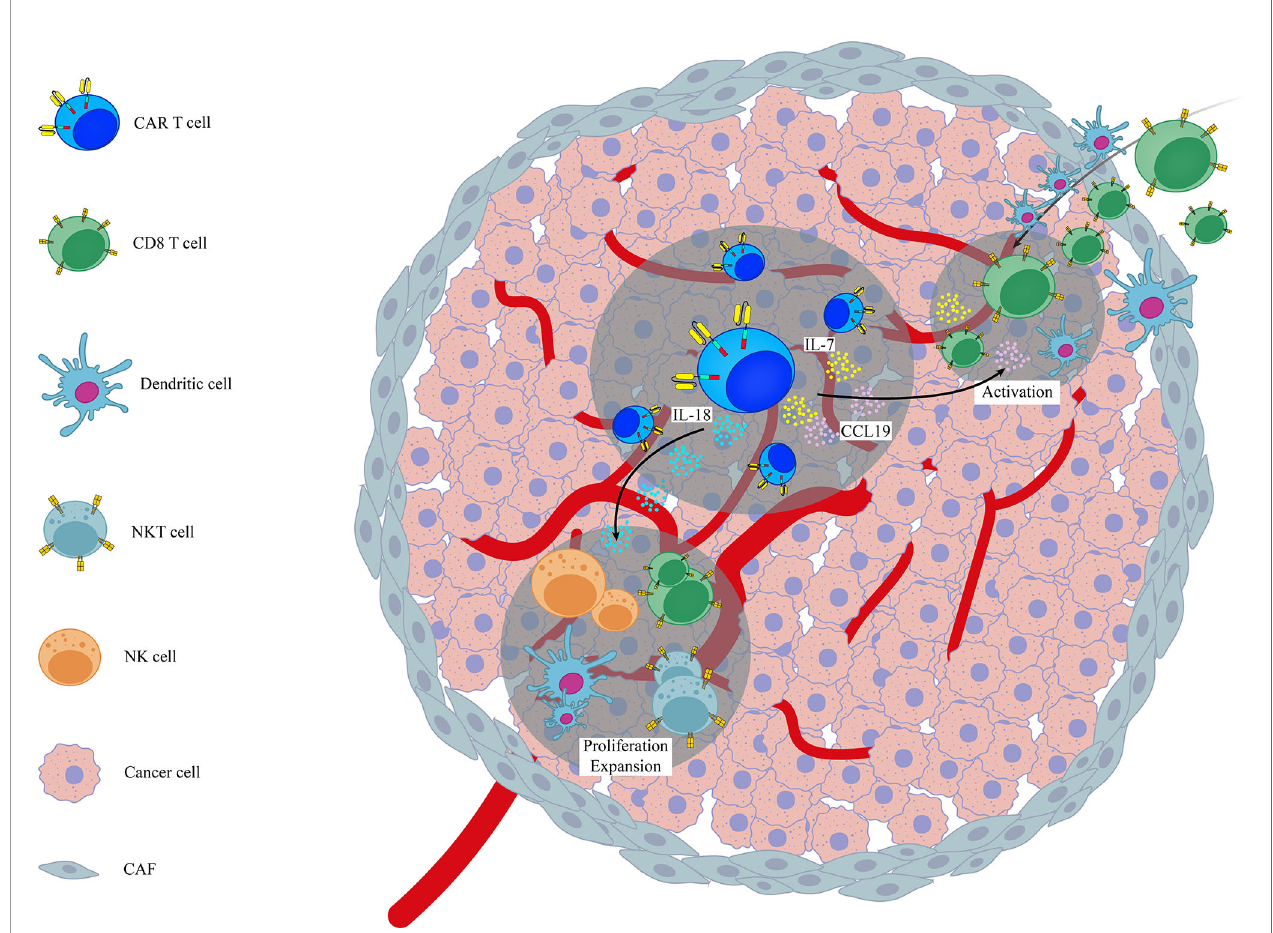
FIGURE 1 | A schematic representation on the role of genetic modi fi cation of different cytokines/chemokines in activation of endogenous immune system in the context of CAR T cell therapy. Examples are based on the role of genetically modi fi ed CAR T cells (7x19 CAR T cells and IL-18 armored CAR T cells) in the activation of endogenous immune cells like CD8+ T cells, NK, NKT and DCs. CAF, Cancer Associated